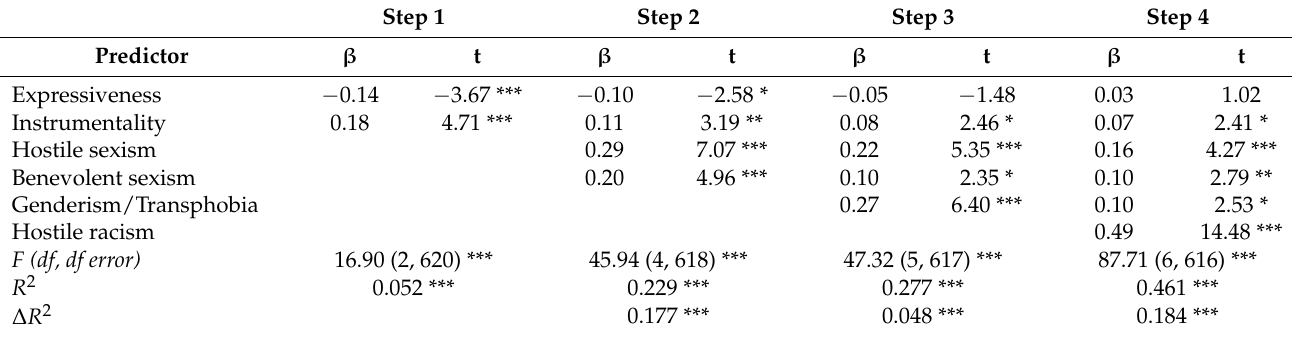
Table 4. Hierarchical linear regression analysis predicting rejection of minority ethnic